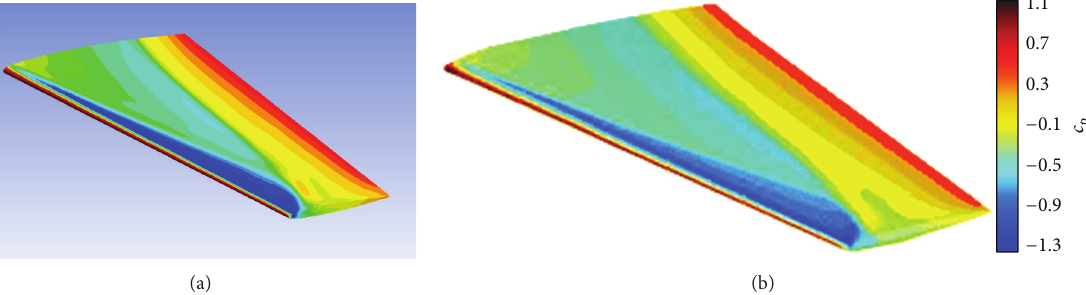
Figure 3: A comparison of the pressure coefficient contours on the upper surface of ONERA M6 wing at 𝛼 = 3.06 deg, 𝑀 ∞ = 0.84 as obtained with (a) CFX solver, (b) a high-order discontinuous Galerkin solver [14] (reproduced with